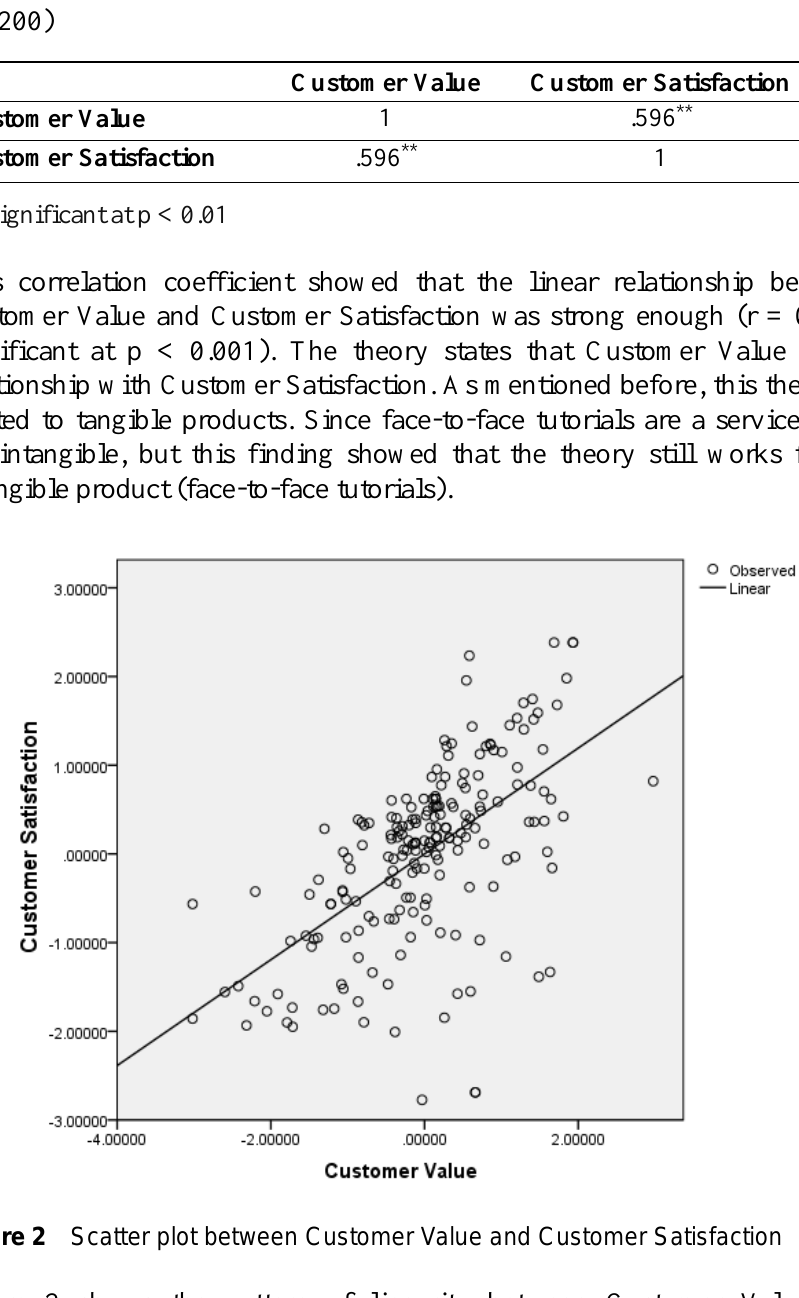
Table 1 Correlations between Customer Satisfaction and Customer Value